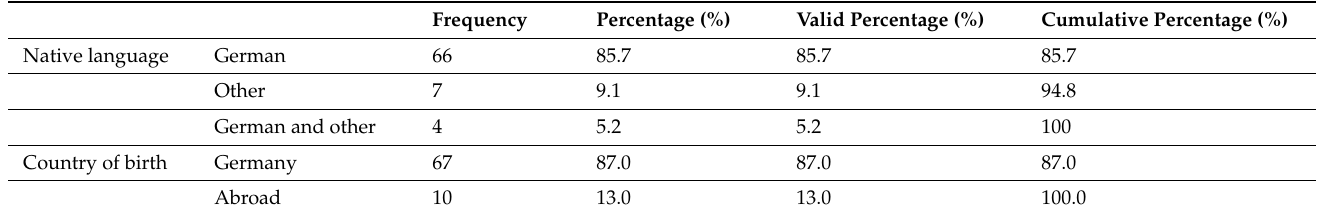
Table 1. Native language and country of